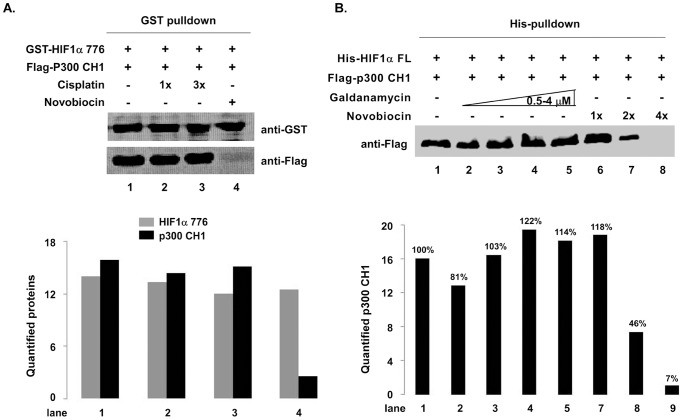
Novobiocin specifically inhibits the interaction between HIF1αCTAD and p300 CH1.
A. Cisplatin did not disrupt the HIF1α CTAD/p300 CH1 complex. A GST pull-down assay was performed by mixing GST fusion HIF1α CTAD, Flag-p300 CH1, and novobiocin (300 µM) or cisplatin (10–30 µM). HIF1α CTAD and p300 CH1 were detected by Western blotting with anti-GST and anti-Flag antibodies (upper panel). Quantified proteins are depicted (lower panel). B. Galdanamycin, an inhibitor of Hsp90, does not affect the interaction between HIF1α and p300 CH1. His pull-down was carried out by mixing purified proteins (combinations indicated in the figure). Bound p300 CH1 protein was detected by Western blotting with anti-Flag antibody. Western blot images were quantified using Quantity One software (lower panel). Percentages given above each bar represents the bound p300 CH1 protein compared to lane 1.